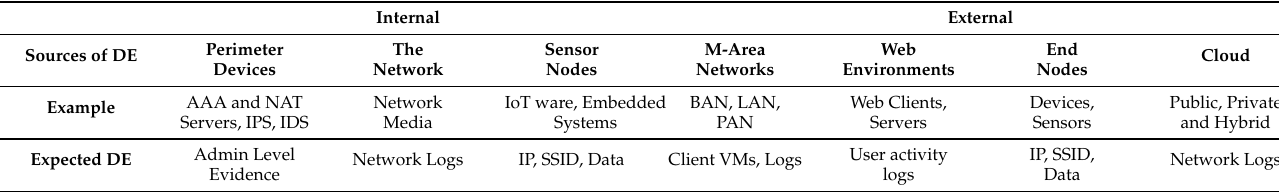
Table 1. The Digital Evidence (DE) in WSN and IoT